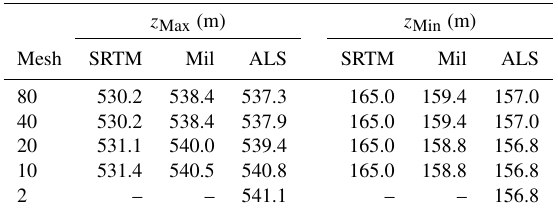
Table 3. Maxima and minima terrain elevation, based on SRTM, Mil and ALS data. z Max (m)